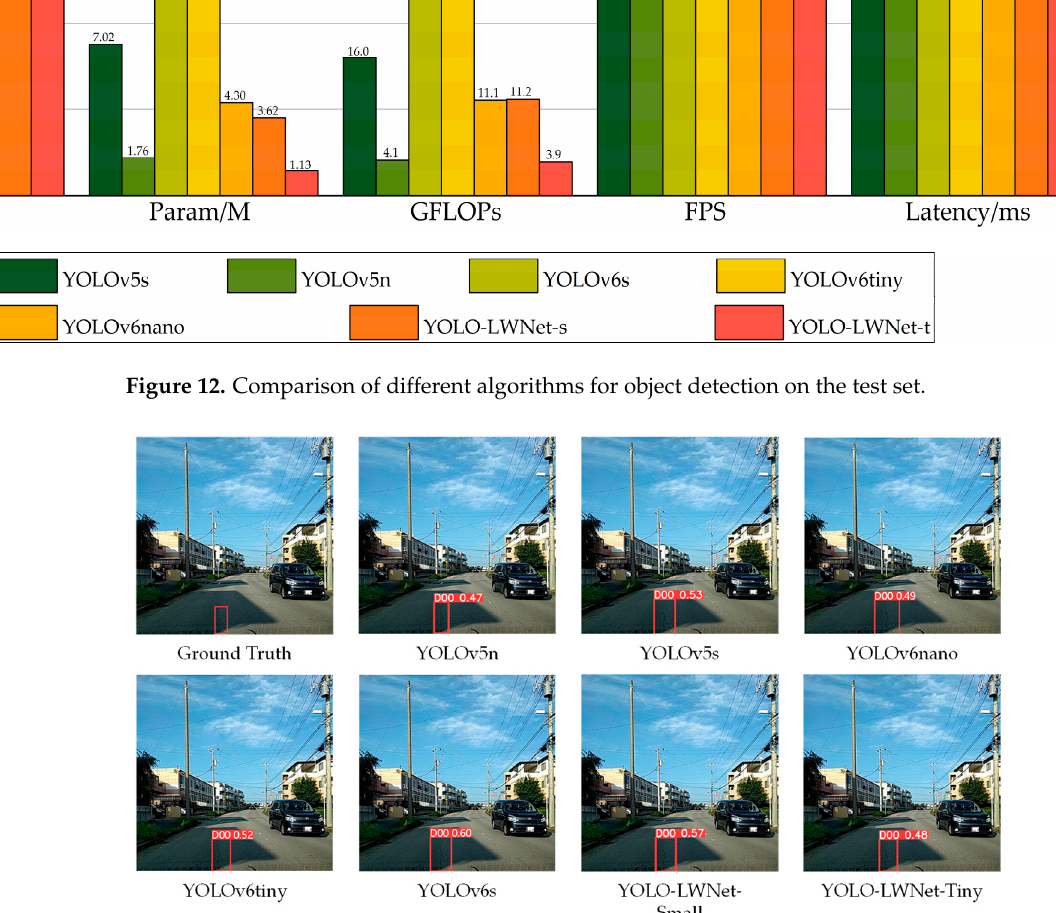
Figure 14. Comparison of the detection of transverse cracks (D10). Figure 15. Comparison of the detection of alligator cracks (D20).